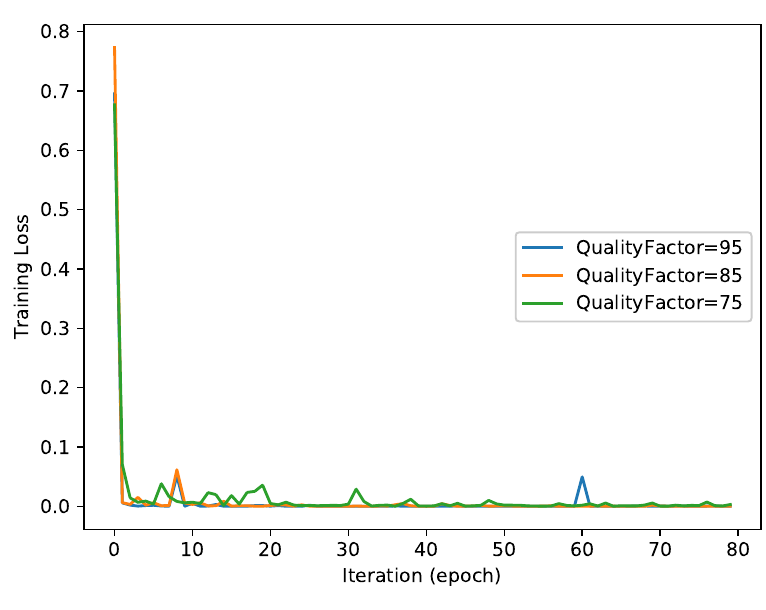
Figure 7. Training loss of the proposed